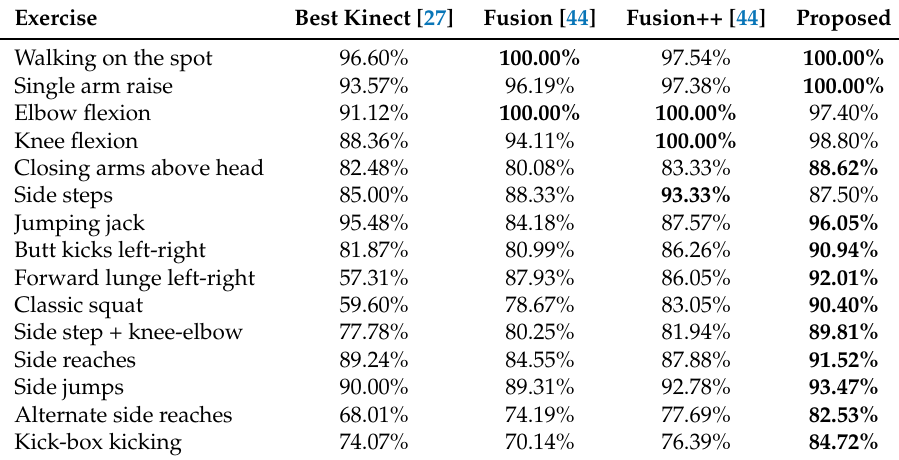
Table 7. Comparative evaluation per exercise using 3D PCK, α 3 D = 20 cm